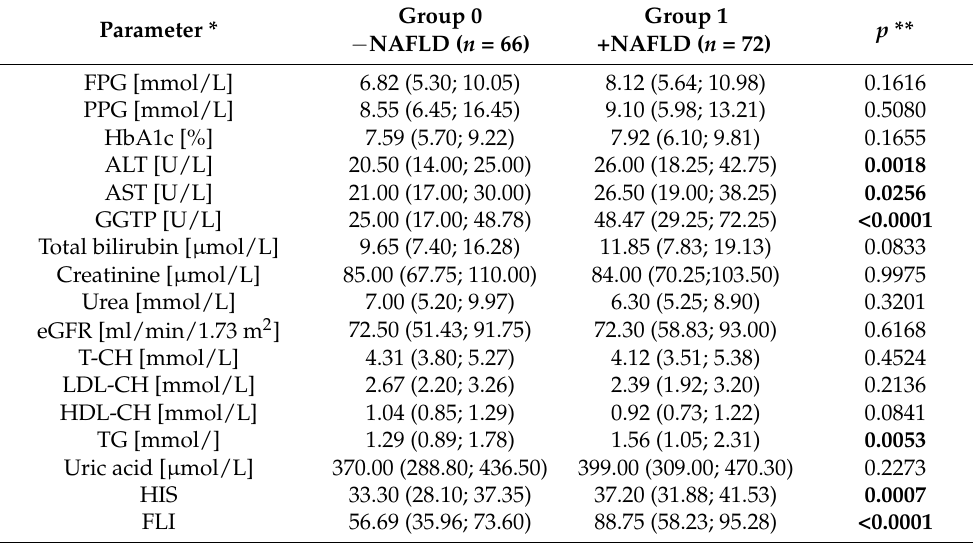
Table 2. Biochemical characteristics of the study